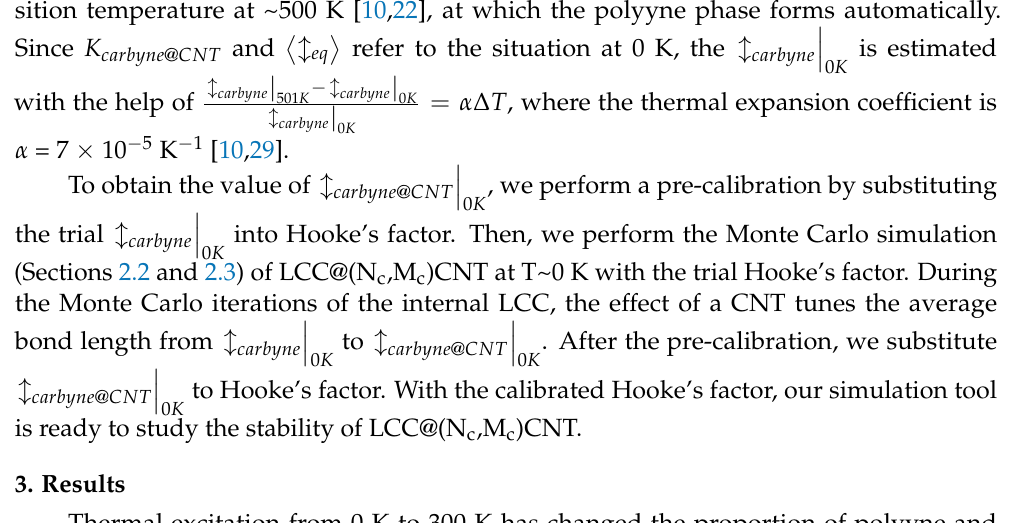
Figure 3. ( a ) The stability of the 6000-atom-long carbyne@nanotube depends on the radius of carbon nanotube R CNT and the chirality (N c ,M c ). The red chain is LCC while the blue tube is CNT. The temperature of the thermal bath is 300 K. For the chain stability factors near 0.7, the average bond lengths of the LCCs range from ~1.3 to ~1.4 Å. ( b ) The average kink angles of the internal LCCs are plo tt ed accordingly. A kink angle of zero (or pivot angle = 180°) means that the chain is linear. The standard deviation of the LCC@(6,4)CNT is as low as ~0.1.